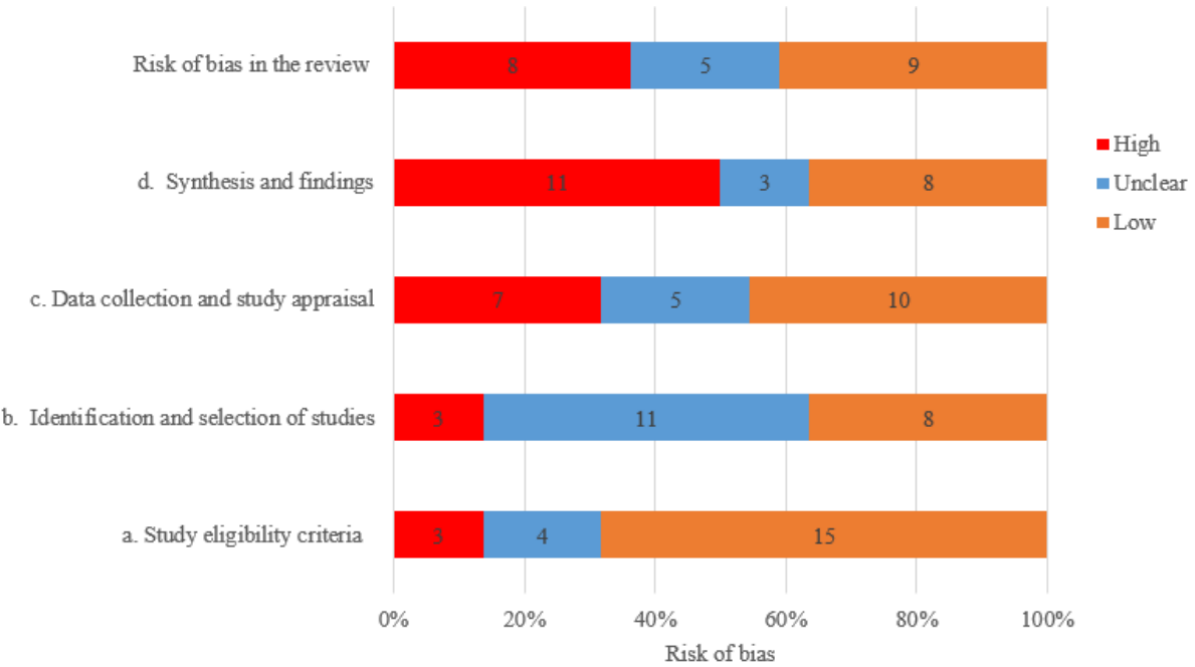
Figure 3. Methodological quality using the Risk Of Bias In Systematic Reviews (ROBIS) tool. The total risk of bias and the four domains of bias are shown. The numbers within the bars represent the number of systematic reviews.